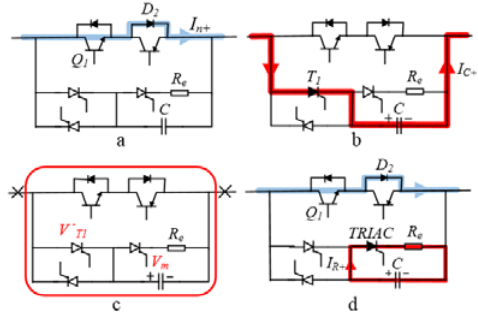
Figure 3. Current flow path of BSCCB: ( a ) Normal Operating Mode;( b ) Blocking Capacitor Charging Stage;( c ) Fault ‐ Current ‐ Blocked Stage;( d ) Reclosing Stage and Dump Energy Releasing Stage.